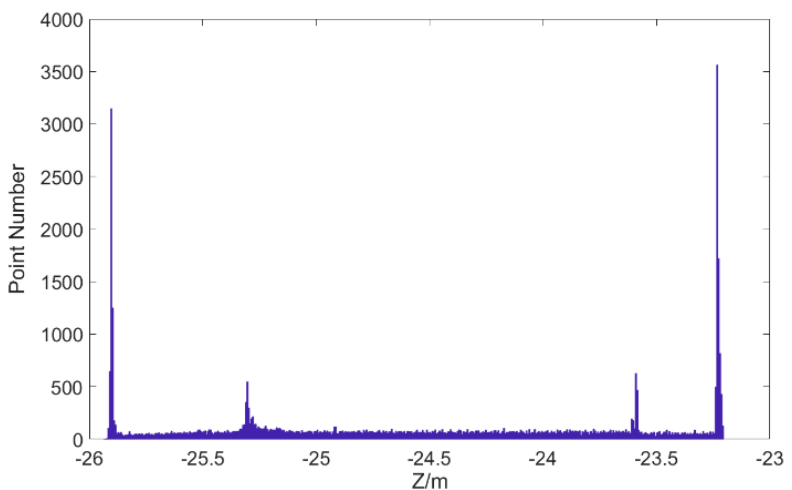
Figure 5. A demonstration of the histogram distribution in Z direction.